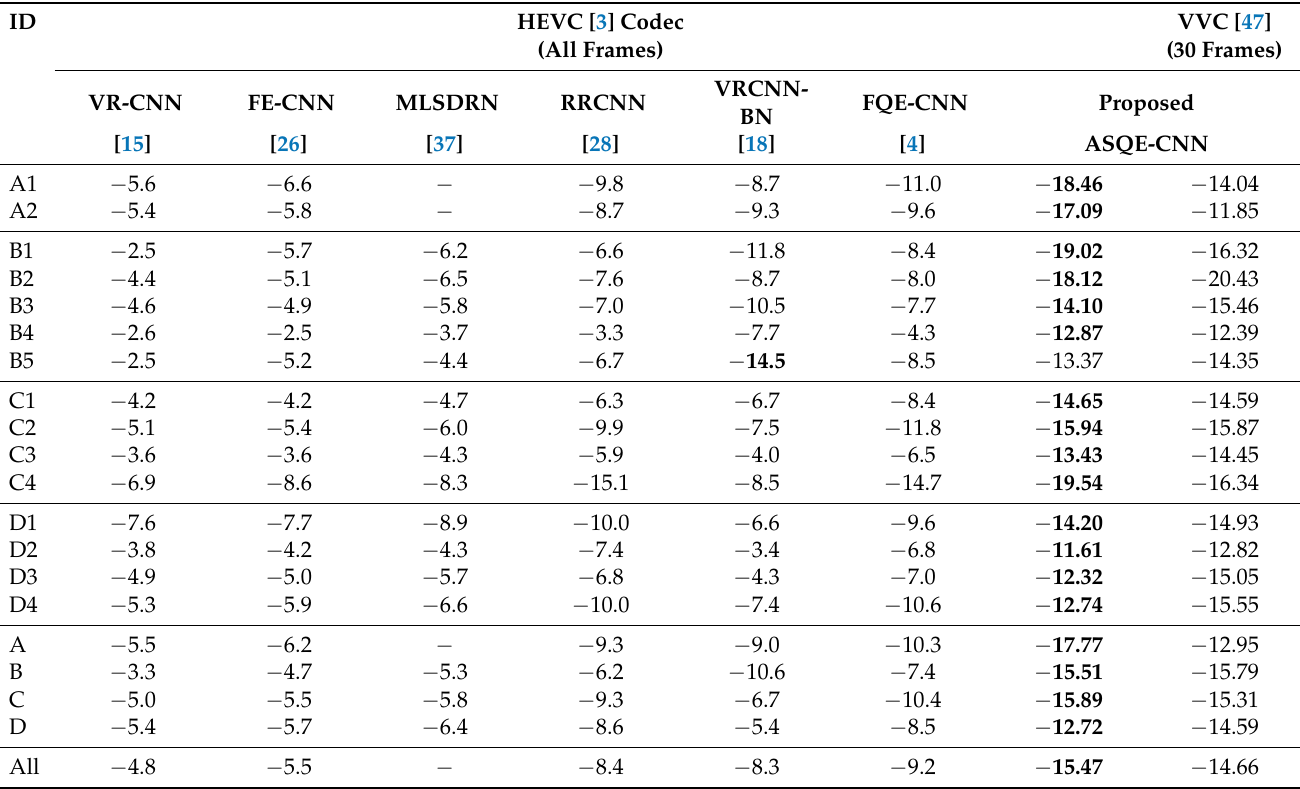
Table 6. Video quality enhancement results computed as Y-BD-rate (%) savings for HEVC- V TSEQ.